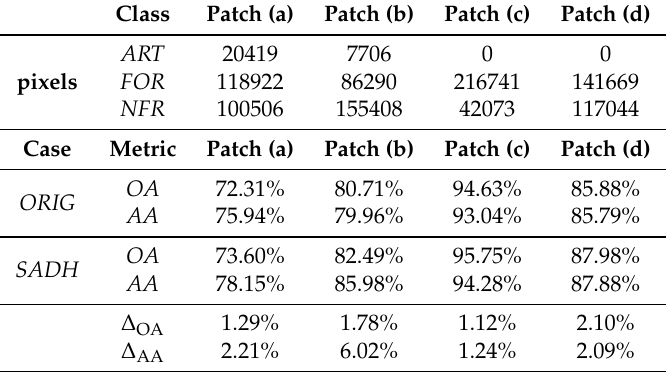
Figure 6. Four analyzed patches of 512 × 512 pixels are placed along the rows. They are indicated as ( a – d ), selected from the classification results over the stack number 7 defined in Table 2. Each column addresses to a different quantity: (REF) is the modified FROM-GLC reference with the clearcuts marked by PRODES between 2017 and 2019 as invalids (INV), (S-1, ORIG) is the Random Forests classification map using the input parameters from [7] only, (S-1, SADH) is the Random Forests result adding the SADH textures to the original parameters, (S-2, RGB) and (S-2, NDVI) are the optical True Color and NDVI maps, respectively, of Sentinel-2 acquisitions from the considered month. (REF), (S-1, ORIG), and (S-1, SADH) maps follow the legend described in Figure 5, while (S-2, NDVI) map comprises three classes: missing data (MDA) in black, forests (FOR) in green, and other structures (OTH) in white. Table 5. Overall accuracy (OA) and average accuracy (AA) for the four patches in Figure 6: patch ( a ) and patch ( b ) are characterized by urban areas, while patch ( c ) and patch ( d ) contain clear-cuts. ∆ OA and ∆ AA represent the increment in (OA) and (AA), respectively, when including textures within the